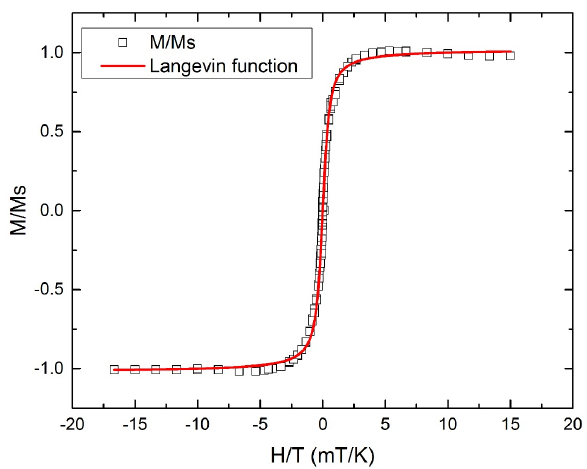
Figure 5. Temperature magnetization data to saturation magnetization M S , are reported as a function of the H/T ratio together with the Langevin fit of the data.